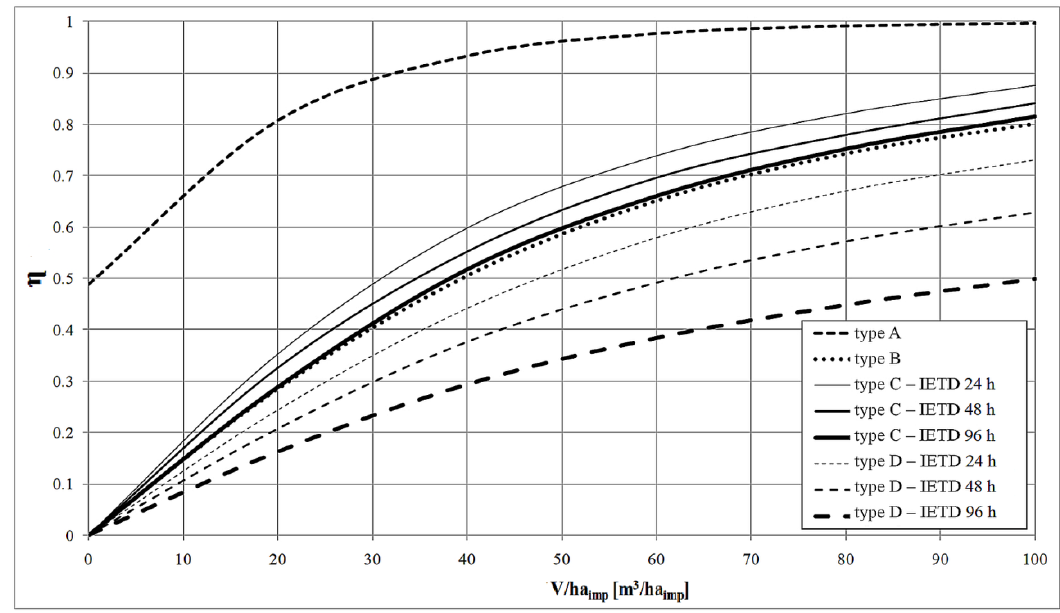
Figure 5. Cervinara station. Efficiency index η compared to tank storage V/h from 0 to 100 m 3 /h aimp